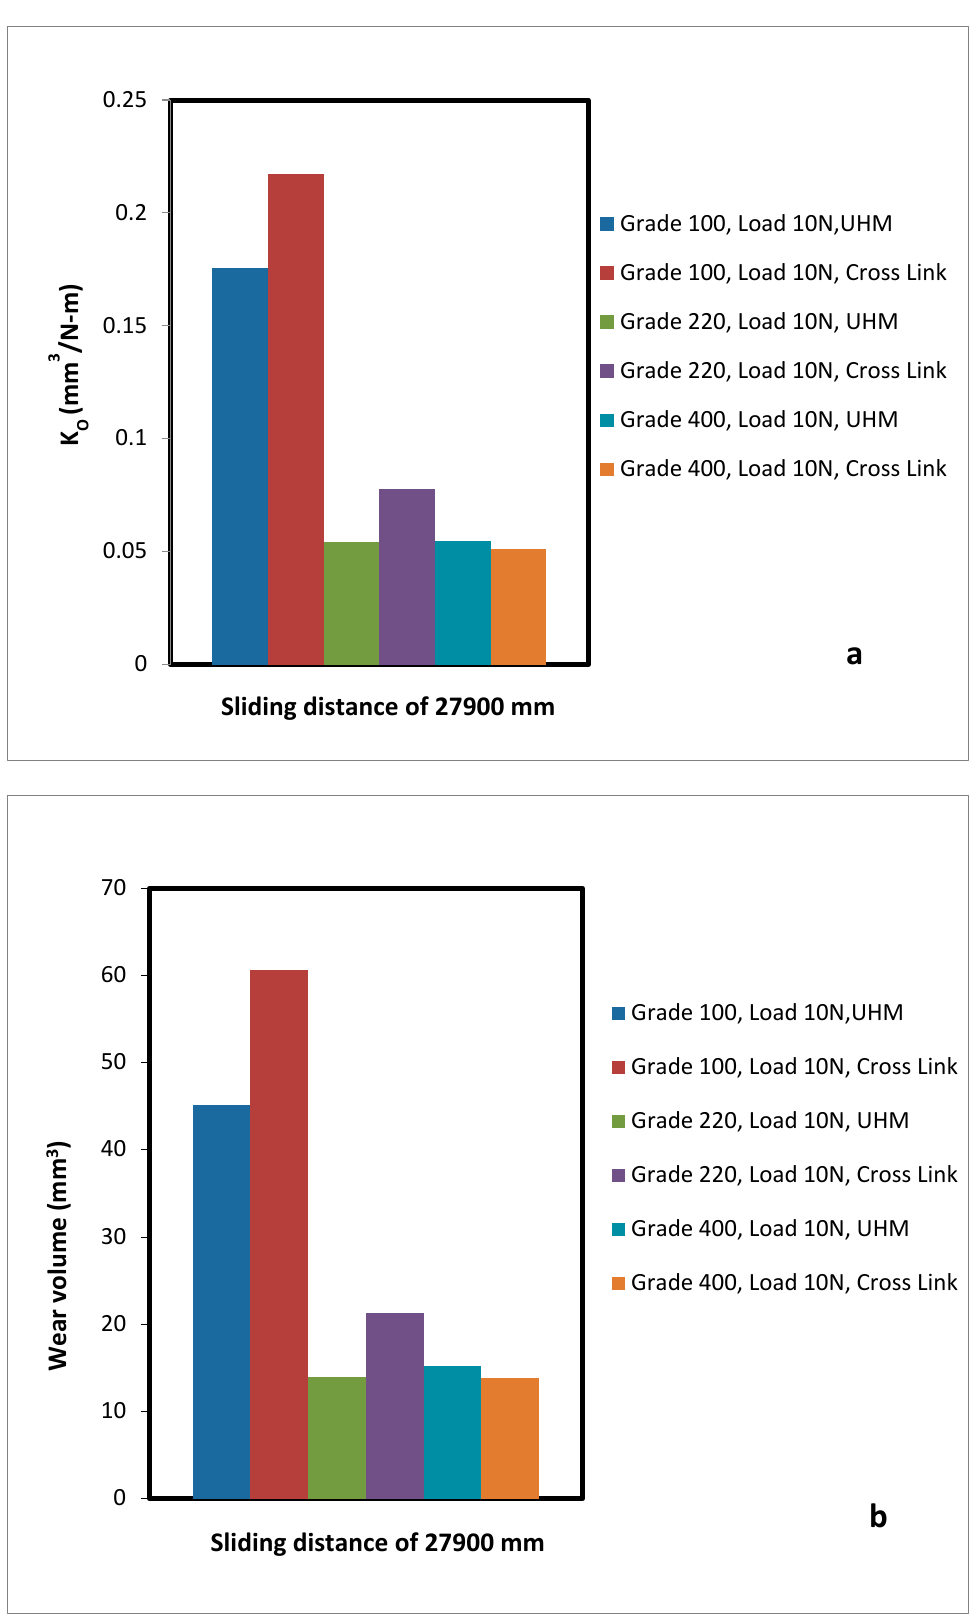
Figure 5. Full Comparison of UHMWPE and Cross-link PE ( a ) Specific wear rate at all wear conditions with load 10 N. ( b ) Wear volume at all wear condition with load 10 N .